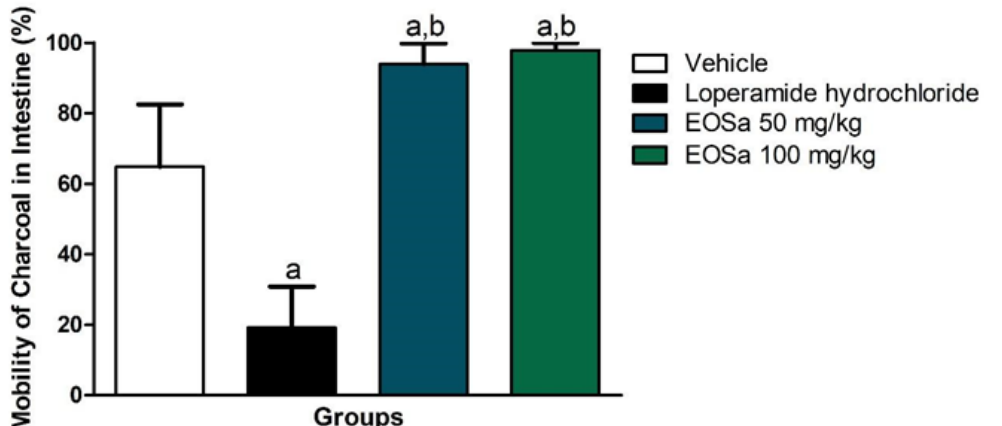
Figure 3. Evaluation of antidiarrheal activity of S. aromaticum essential oil. vehicle: 100 µ L of carboxymethylcellulose (CMC) 1%; loperamide hydrochloride: positive control for diarrhea reduction; EOSa: essential oil of S. aromaticum . a p < 0.01 compared to vehicle; b p < 0.0001 Compared to loperamide hydrochloride, one-way